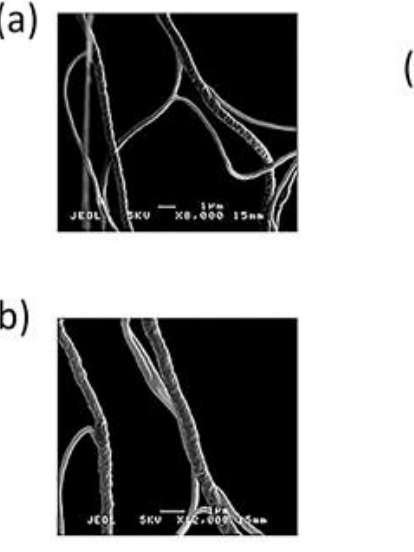
Figure 24. SEM images of ( a ) progesterone-loaded PEO fibres (produced from a solution containing 5% wt. progesterone and 15% wt. PEO), ( b ) progesterone-loaded PEO/CMC fibres (produced from a solution containing 5% wt. progesterone, 13.75% wt. PEO and 1.25% wt. CMC), and ( c ) Progesterone loaded PEO and PEO/CMC fibres and Cyclogest release profiles in stimulated vaginal fluid [175], copyright 2018 Elsevier.